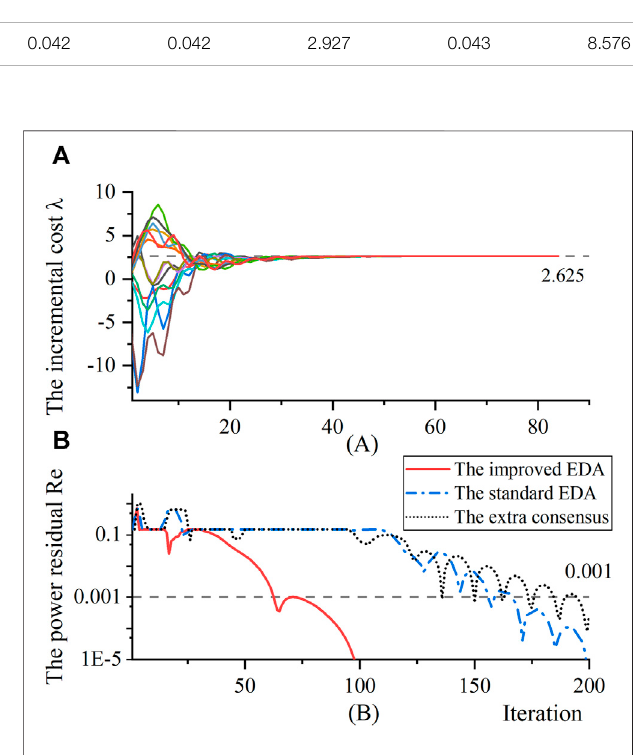
FIGURE 9 | (A) The convergence process (B) The power residual